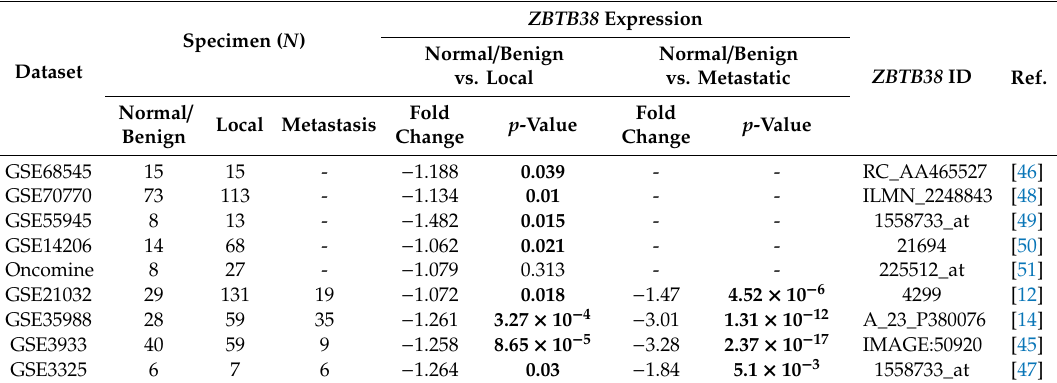
Table 1. ZBTB38 expression in localised and metastatic prostate